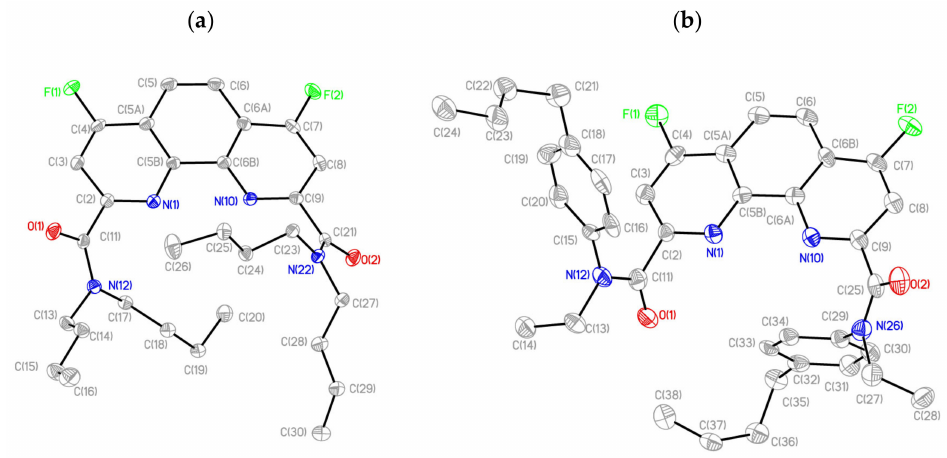
Figure 4. Structure of ligands 7a ( a ) and 7c ( b ) in representation of atoms be ellipsoids of atomic displacement parameters. The H-atoms and disordered alkyl chain in 7c are omitted for clarity.